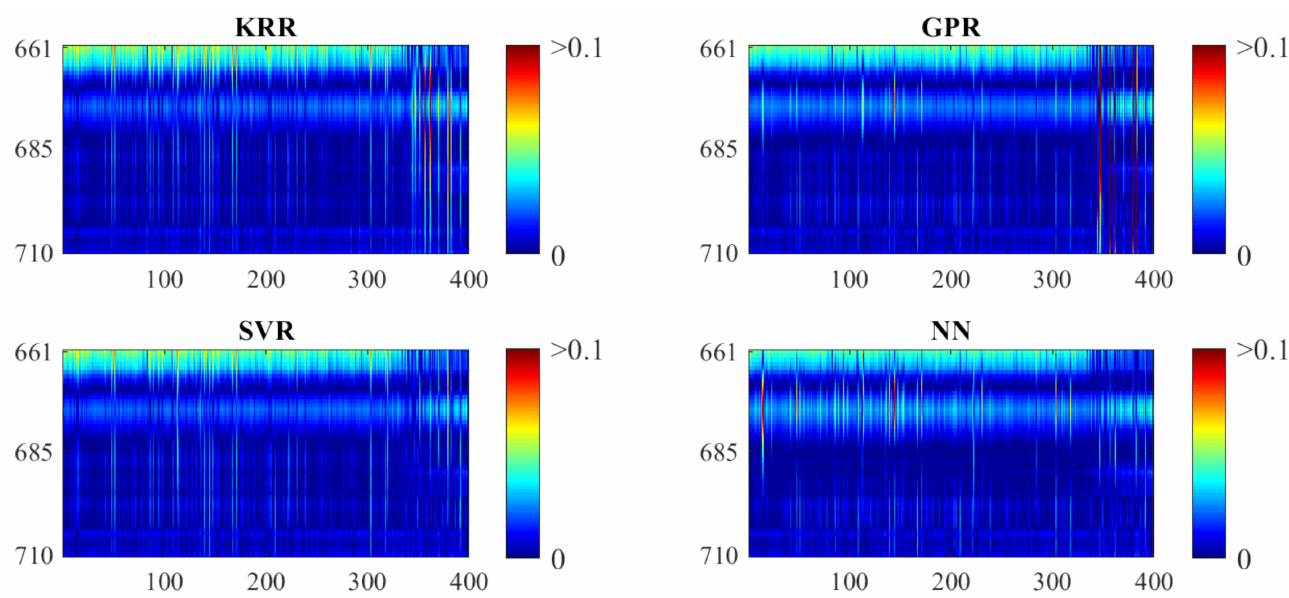
Figure 7. Relative error between the “reference data” from VDB and the retrieved Rrsn − SICF ( λ ) in the spectral range between 661 and 710 nm for each MLRA trained. The X -axis is the number of validated spectra (1 to 400) and the Y -axis are the wavelengths of the estimated bands. The scale color represents the relative error values, the blue being the lower errors, and the red being the higher errors. Table 3. Summary of statistical results and training/testing time of validation of each MLRA